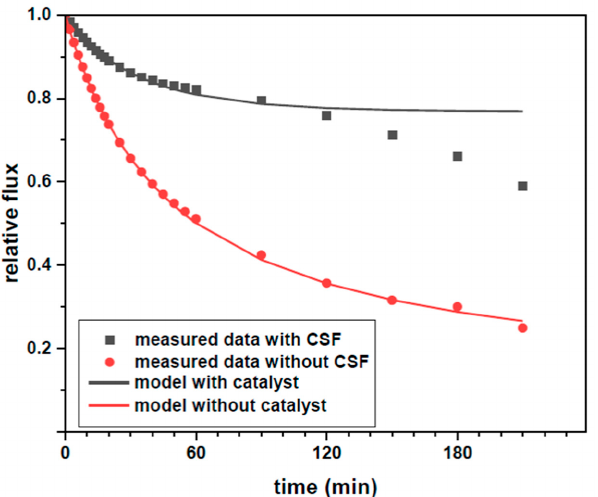
Figure 5. Comparison of change of relative flux in time for effluent with and without thermocatalyst; bullets indicate experimental points; lines correspond to an intermediate pore blocking model (Supplementary Materials).